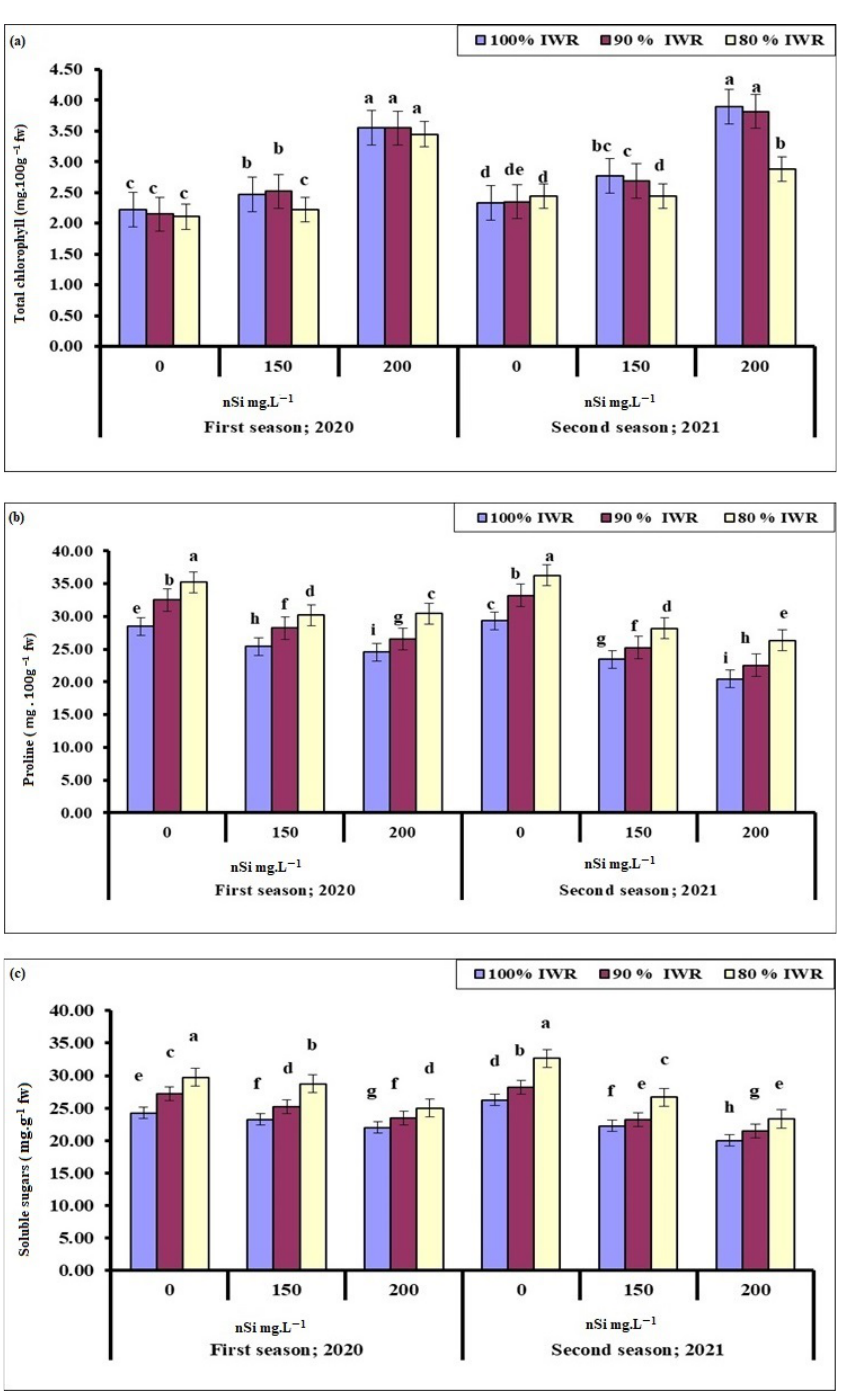
Figure 2. Effect of foliar sprayed nano-silicon (nSi) under different irrigation regimes on the leaf total chlorophyll ( a ), proline ( b ), and soluble sugars ( c ) of ‘Kalamata’ olive trees during the 2020 and 2021 seasons ( n = 10). Means with similar letters for each season are not significantly different, using Duncan’s multiple range test (DMRT) at p ≤ 0.05. Error bars represent the standard error of the